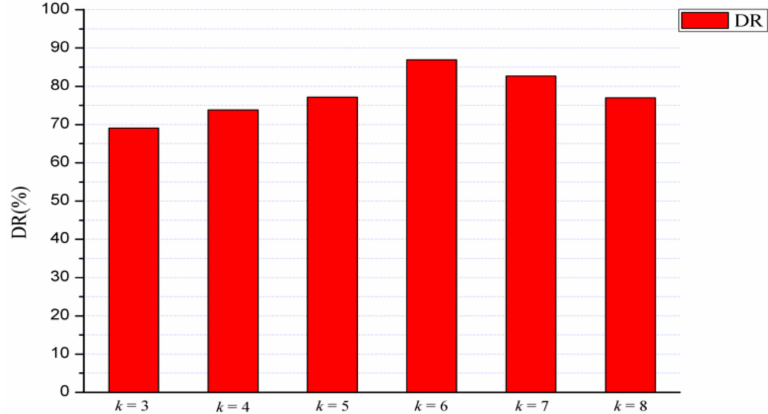
Figure 9. The comprehensive detection rate of di ff erent k on UNM_live_lpr data.